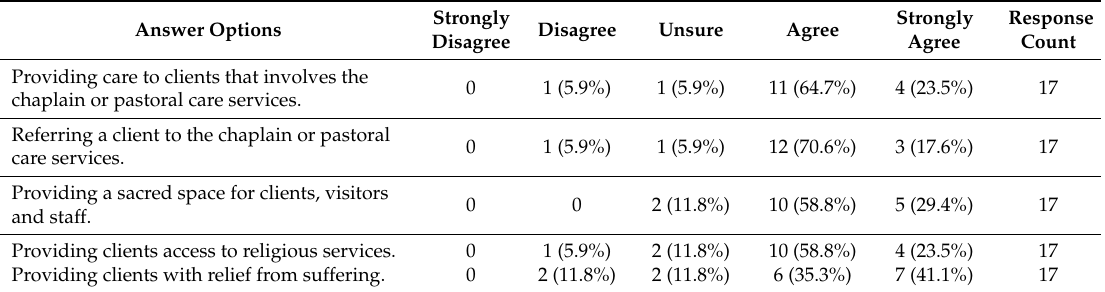
Table 8. The extent to which respondents believe that the competencies outlined by van Leeuwen and